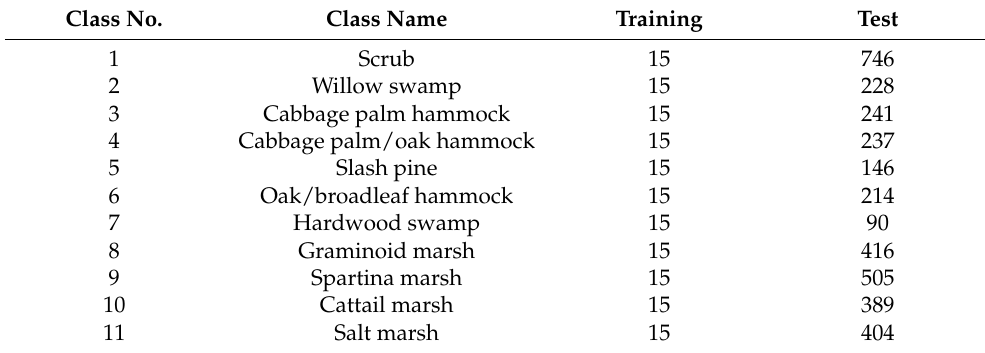
Table 6. The land cover category and data division on the Kennedy Space Center dataset. Class